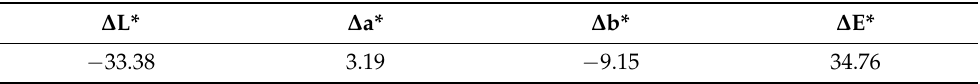
Table 4. Lightness and chromatic parameters variation due to industrial heat treatment.